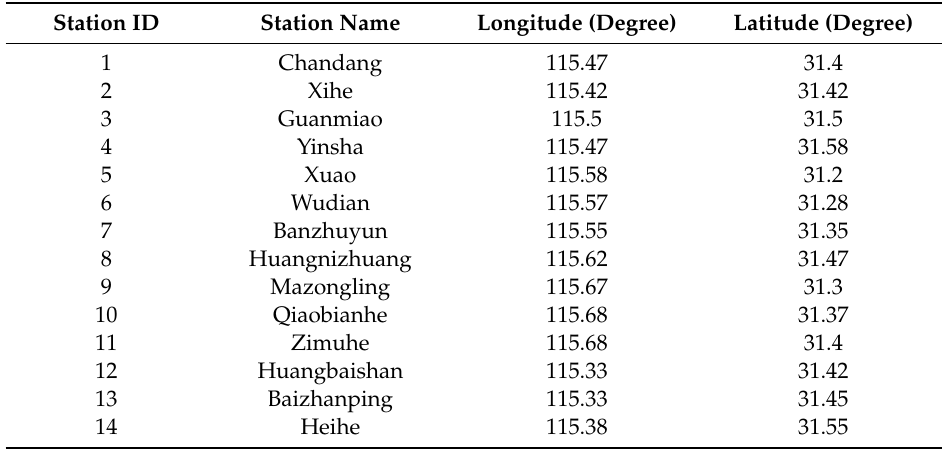
Table 2. Meteorological gauge stations at the upstream Shiguan River